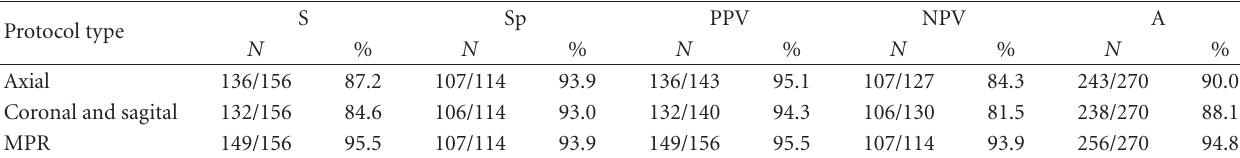
Table 3: Evaluation of the sensitivity (S), specificity (Sp), positive predictive value (PPV), negative predictive value (NPV), and accuracy (A), according to the protocol type, in the study of the presence or absence of simulated lesions.